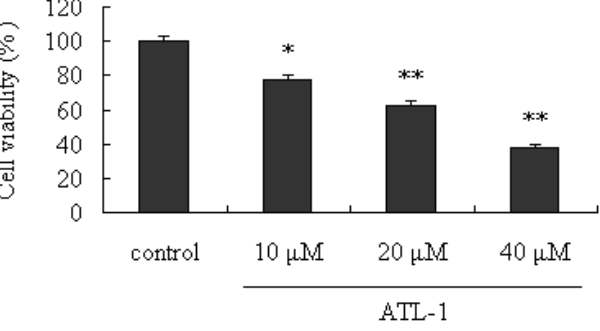
Figure 1. Cytotoxic effects of ATL-I on A549 cells. Cells were treated with ATL-I at the concentrations of 10, 20, and 40 μ M for 48 hours, the cells viabilities were determined by